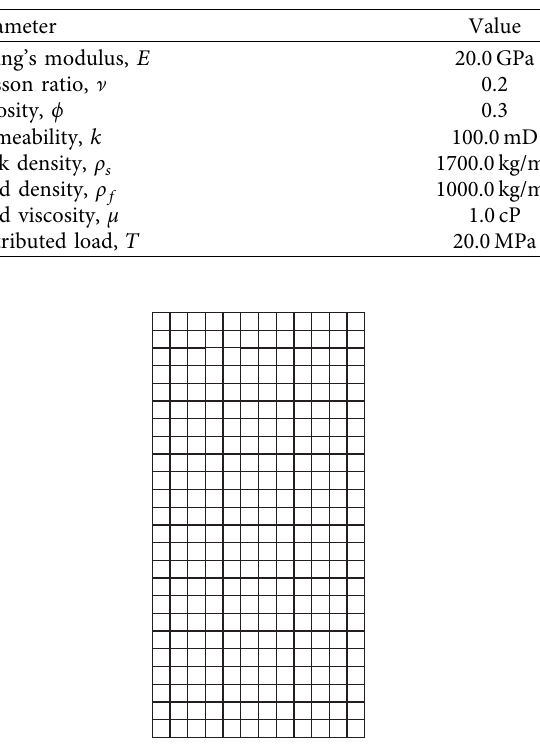
Table 1: Parameters of Terzaghi’s problem.